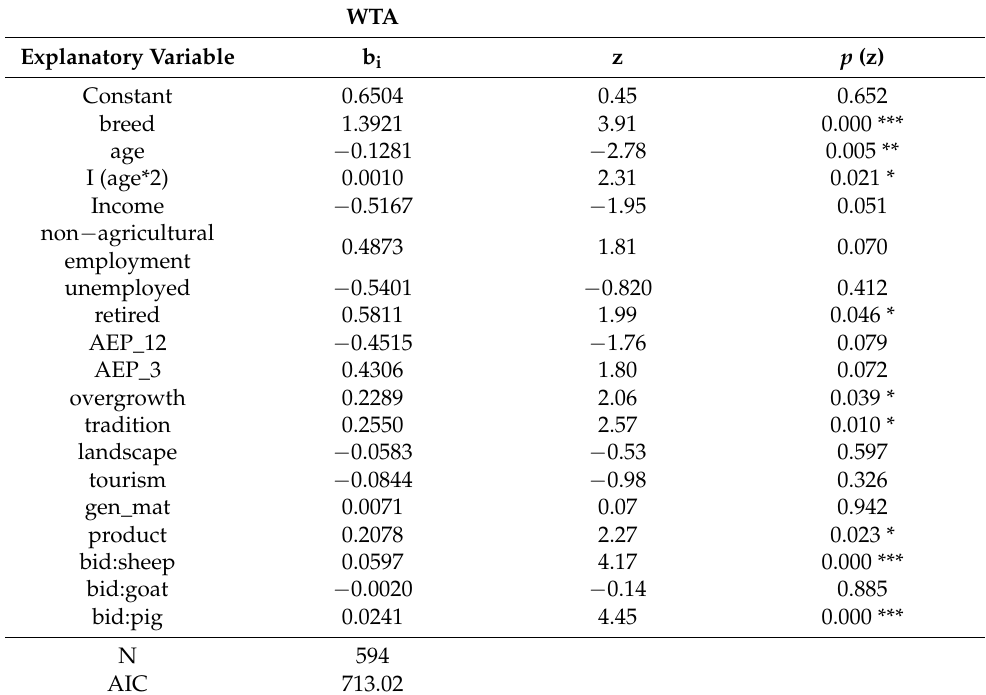
Table 6. WTA logistic regression estimation